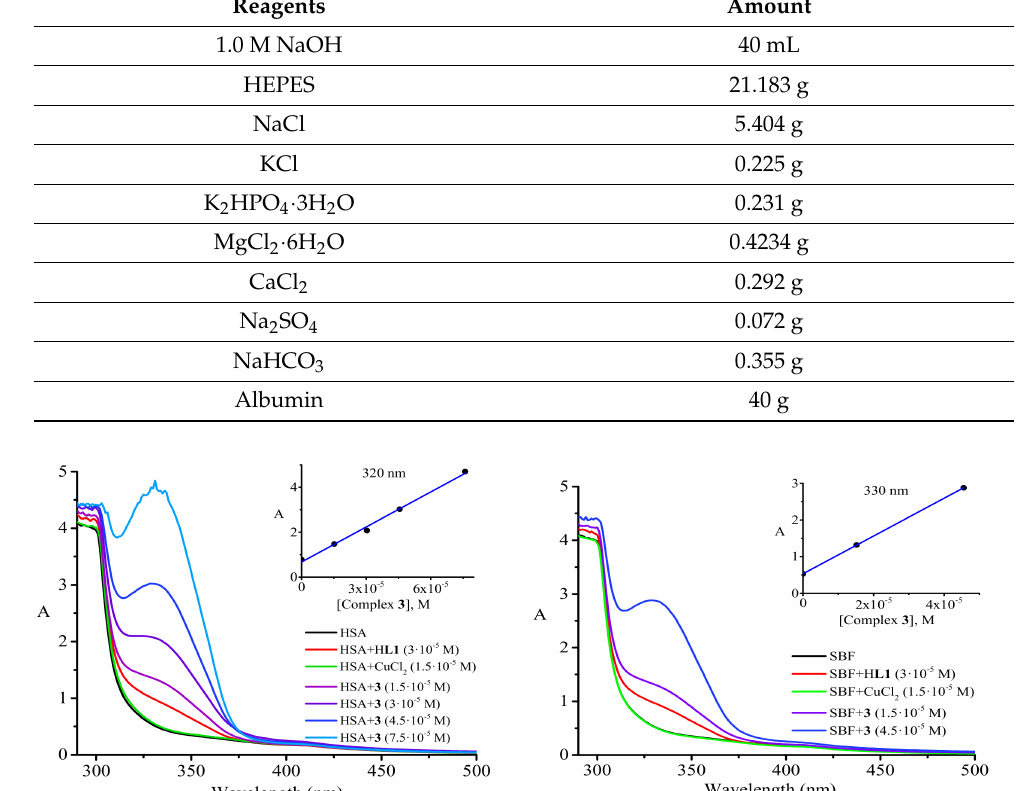
Figure 5. Absorption spectra of HSA and SBF solutions in the absence and presence of H L1 , CuCl 2 , as well as [Cu( L1 ) 2 ] with increasing concentrations of the latter. Inset plots display absorbance vs. concentration of complex 3 for HSA/SBF